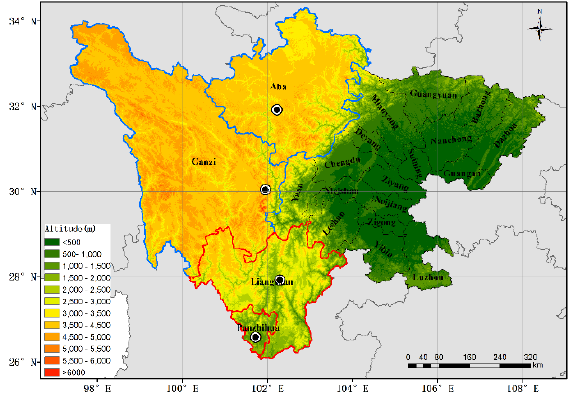
Figure 1. Geographical position of ecological zone ( blue outline ) and economic zone ( red outline ) of Western Sichuan Plateau, the locations of cities are marked by black dots.